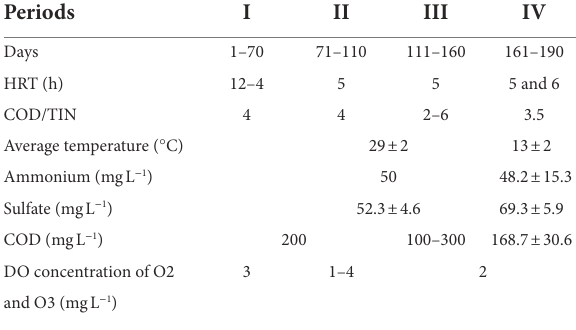
TABLE 1 Influent parameters of the